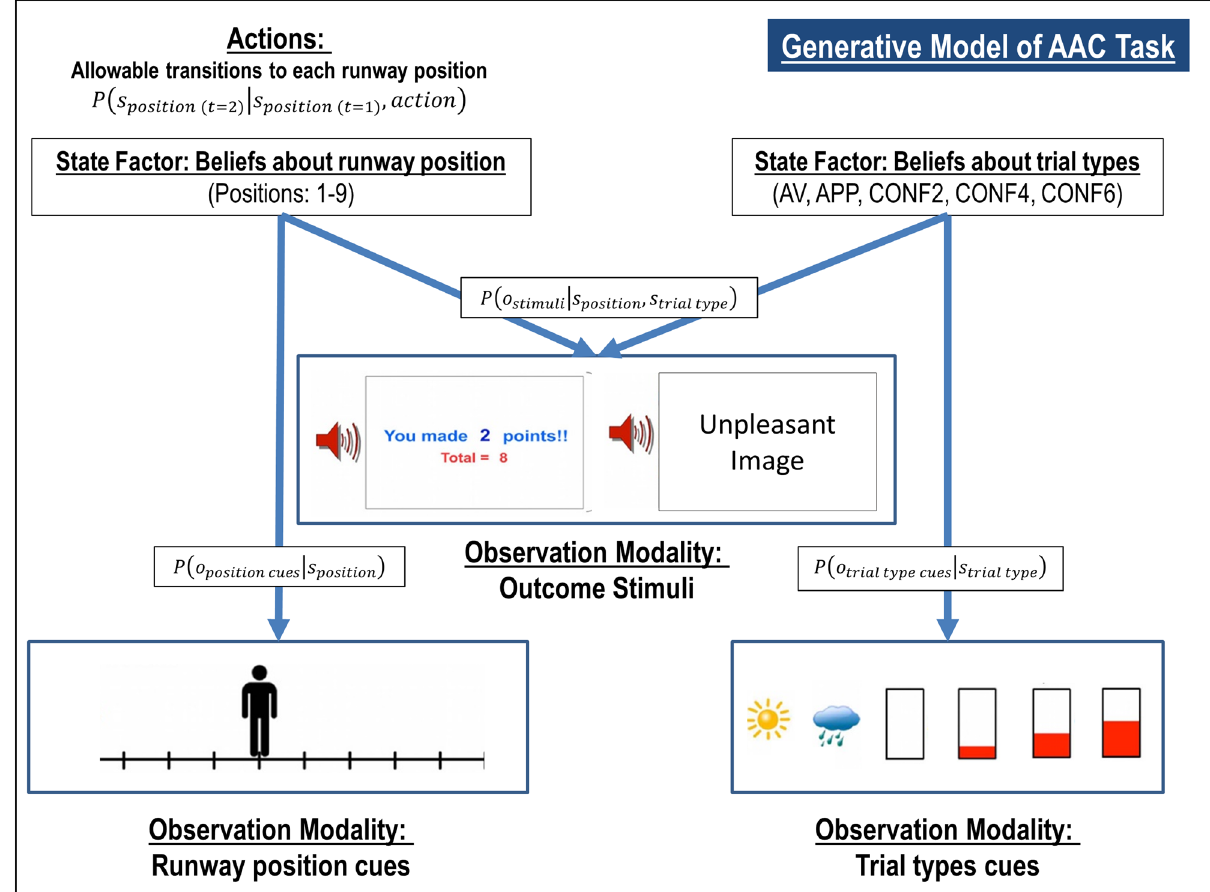
Figure 2. Simplified visual depiction of relevant dependencies in the computational (generative) model of the approach-avoidance conflict task. Beliefs about trial type and beliefs about runway positions were generated by (and inferred based on) trial type cues and runway position cues, respectively. Observed outcome stimuli were probabilistically generated by an interaction between trial type and runway position. Beliefs about this interaction were used to infer the action (state transition) most likely to produce the most preferred outcome stimuli. Trial Types: AV = Avoid; APP = Approach; CONF2, CONF4, and CONF6 indicate Conflict + 2 Points, 4 Points, or 6 Points, respectively. This figure is modified from our previous paper 20